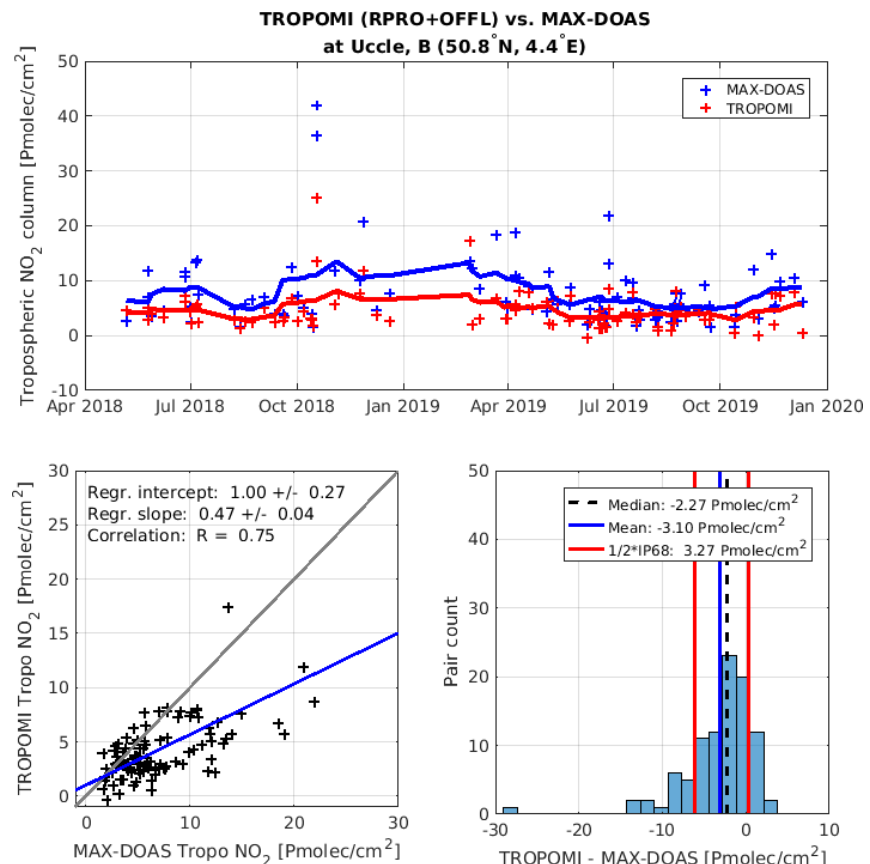
Figure 8. Same as Fig. 4 but now for the S5P OFFL tropospheric NO 2 column data co-located with ground-based MAX-DOAS measurements performed by BIRA-IASB at the NDACC mid-latitude station of Uccle in Brussels